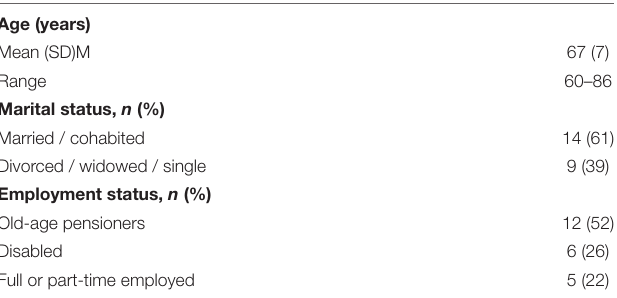
TABLE 1 | Characteristics of the participants ( n =